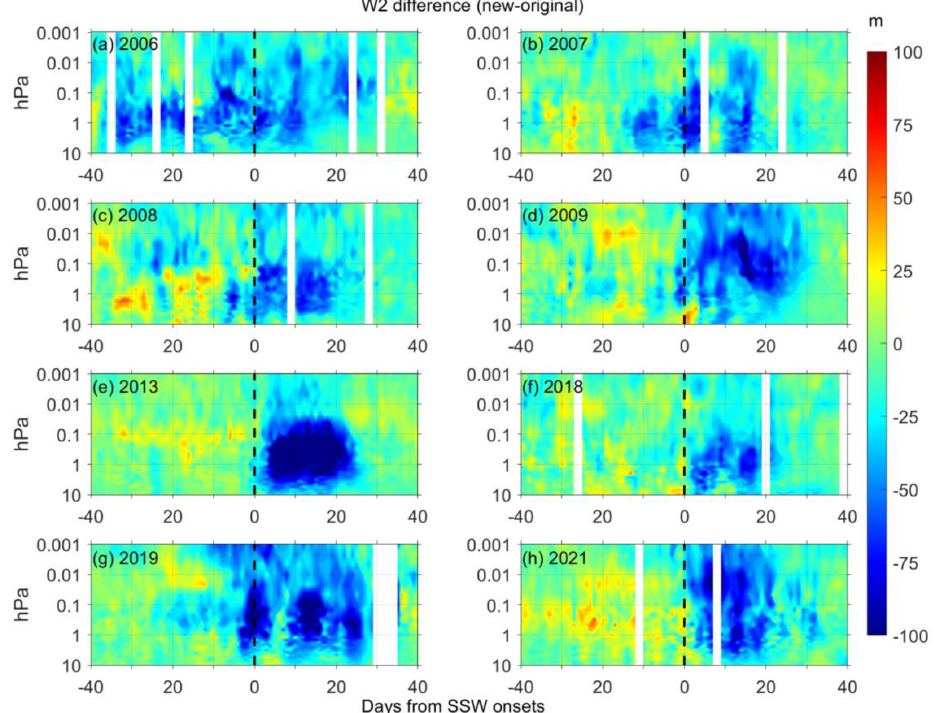
Figure 7. Same as Fig. 6 but for the W2